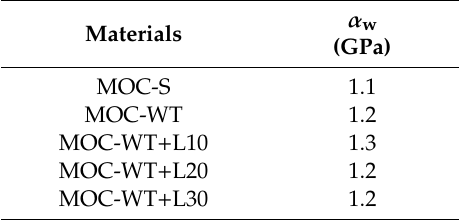
Table 8. The water resistance coe ffi